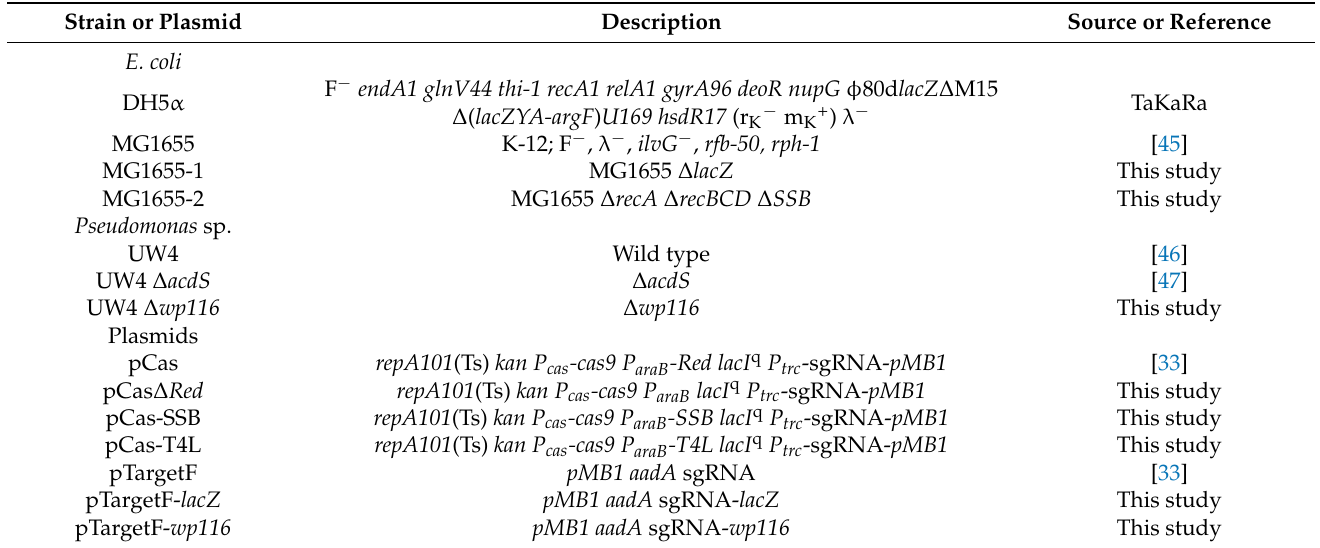
Table 1. Strains and plasmids used in this study a